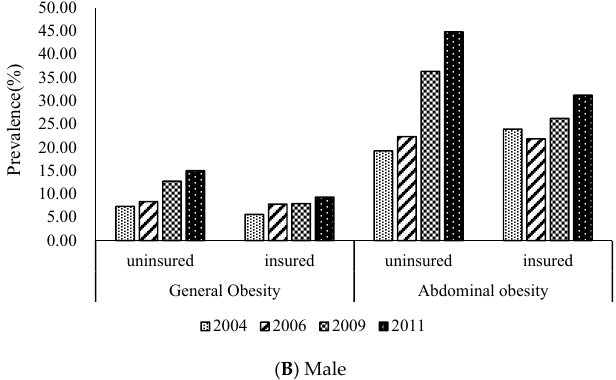
Figure 1. Trend of general obesity and abdominal obesity in Chinese rural residents (Female ( A ) and Male ( B )) by insurance status from 2004 to 2011.